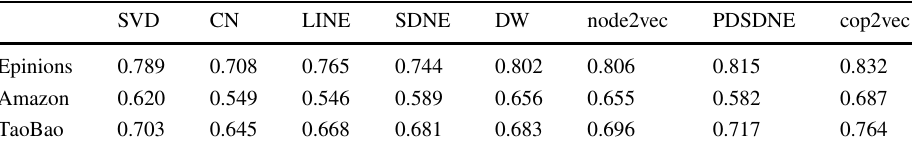
Table 3 Area under curve (AUC) scores for co-purchaser